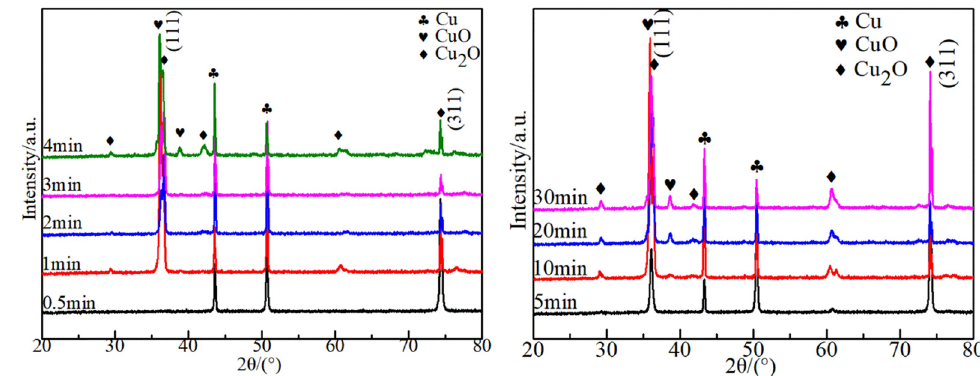
Figure 4: Results of copper surface XRD analysis in an ethanol combustion atmosphere.